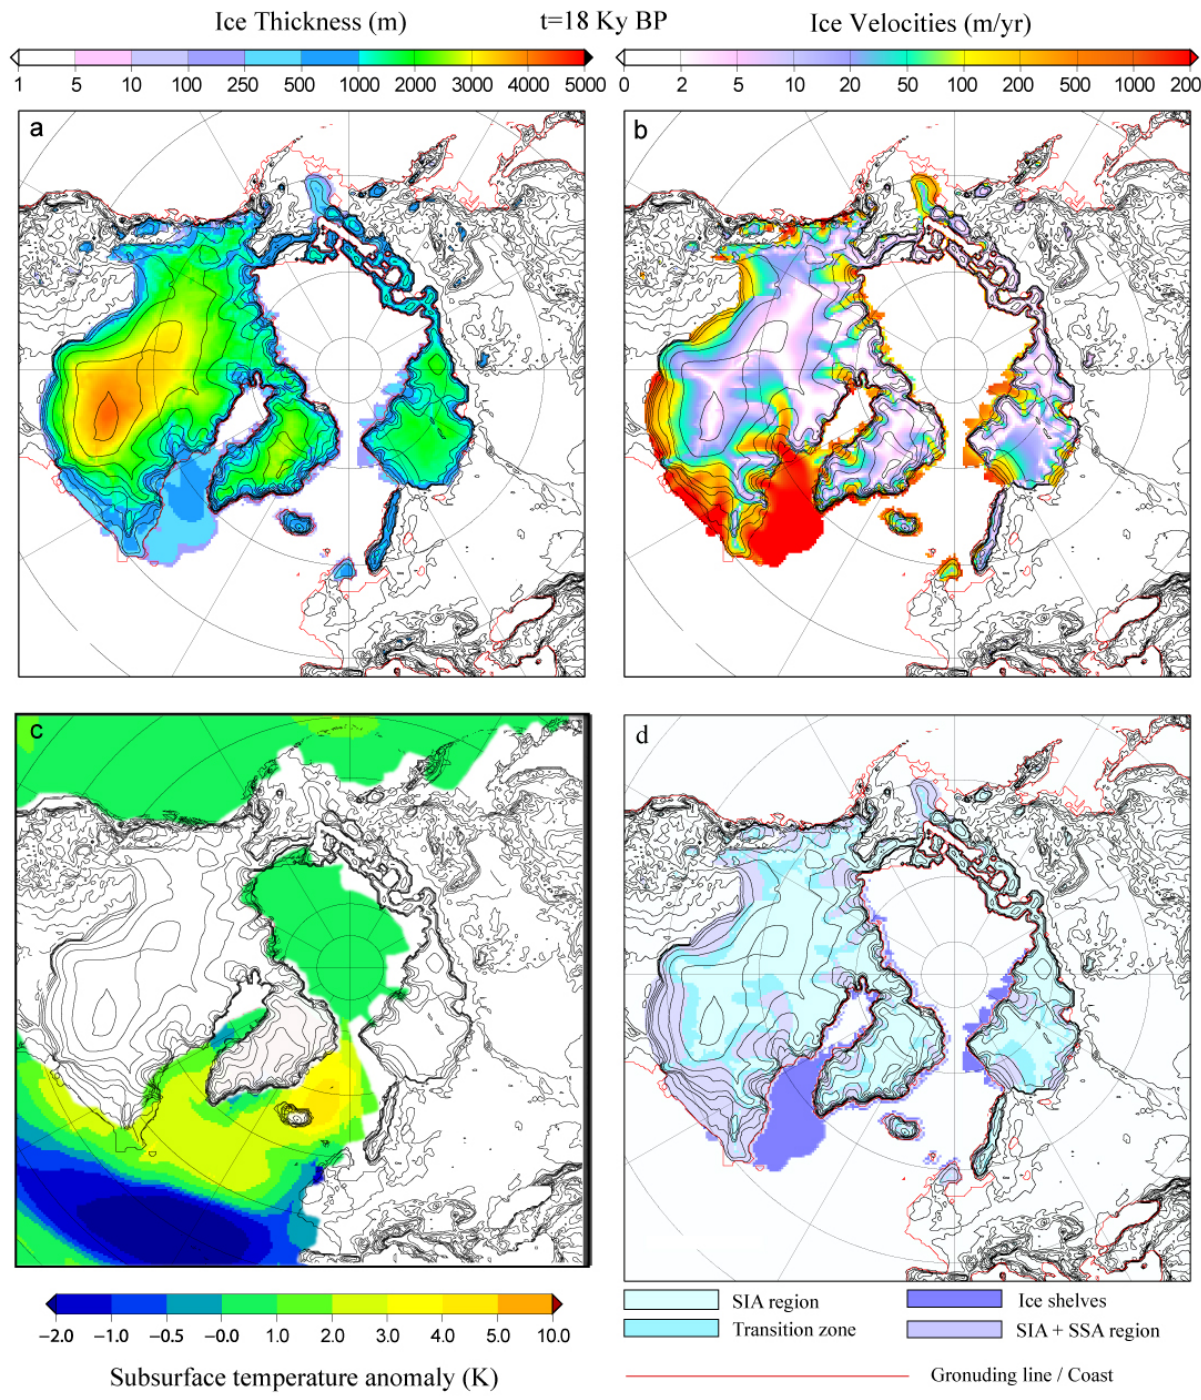
Fig. 1. Northern Hemisphere ice sheets simulated by the GRISLI model at 18kaBP, prior to Heinrich event 1, in terms of ice thickness (a) , ice velocities (b) and subsurface (550–1050 m) mean annual temperature anomaly (in K) in response to the shutdown of Nordic Seas deep water formation (c) . This temperature anomaly and the corresponding ice-shelf basal melting has been considered during the period 18– 17kaBP. Panel (d) illustrates the different parts of the ice sheet in terms of its dynamics. SIA and SSA mean Shallow Ice Approximation and Shallow Shelf Approximation